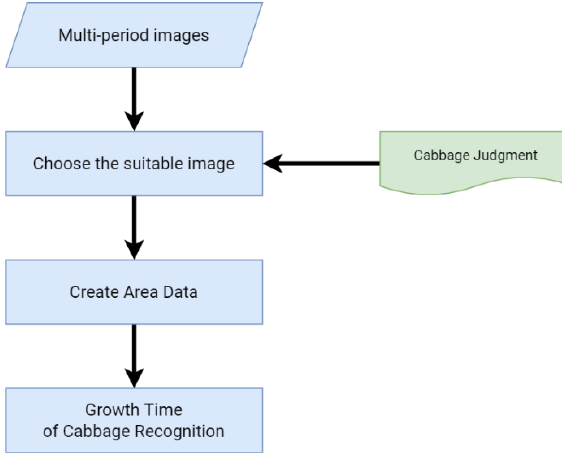
Figure 6. Differential image classification flowchart.